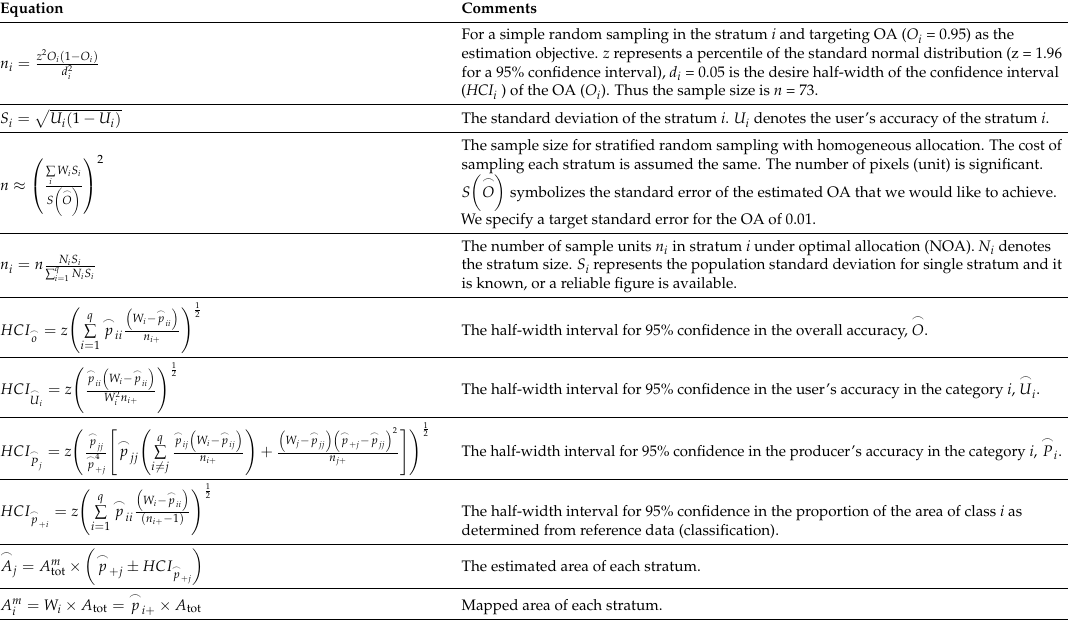
Table 3. Sample size estimation and accuracy assessment [27,28].